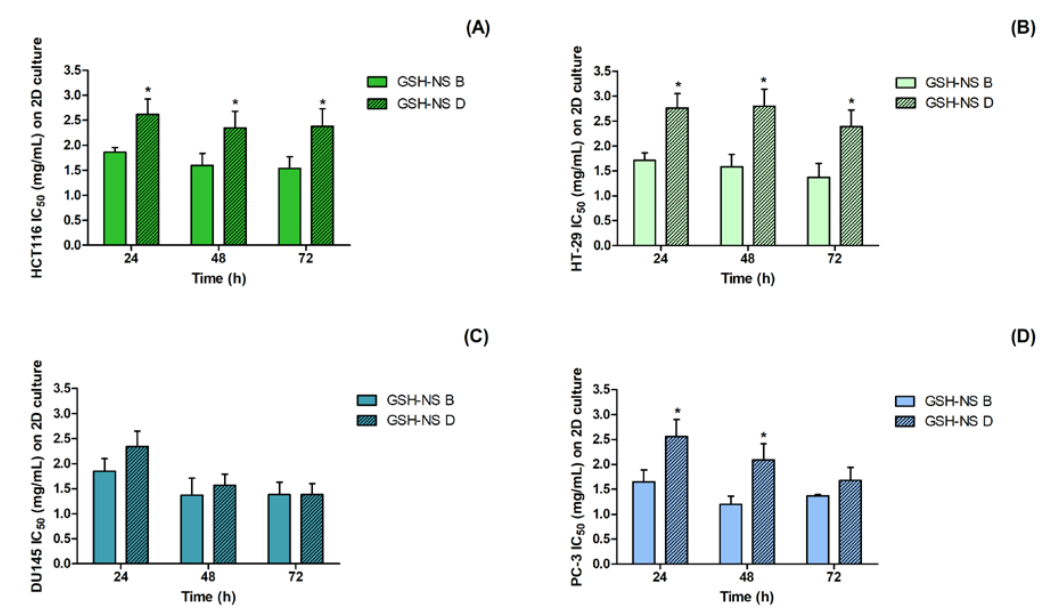
Figure 2. Cytotoxicity of glutathione responsive β -cyclodextrin-based nanosponges in 2D cell cultures. HCT116 ( A ), HT-29 ( B ), DU145 ( C ), and PC-3 ( D ) cells were incubated with GSH-NS B and GSH-NS D at different concentrations (0.5, 1.0, 2.0, 3.0 mg/mL) for 24, 48, and 72 h. Cell